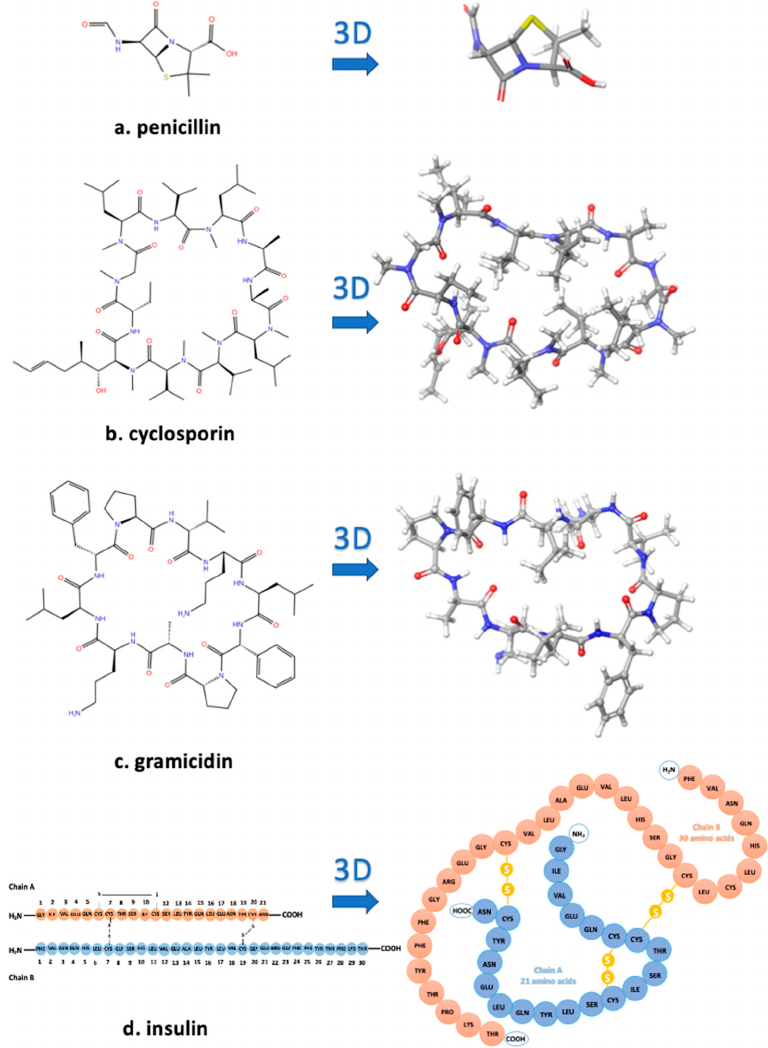
Figure 1. The 2D and 3D structures of well-known cyclic peptides. ( a ) Penicillin is one of the most powerful antibiotics. ( b ) Cyclosporin is a natural product used as an immunosuppressant medication. ( c ) Gramicidin exhibits strong antibiotic activity. ( d ) Insulin is a hormone that plays a key role in the regulation of blood glucose levels, and its deficiency causes diabetes.